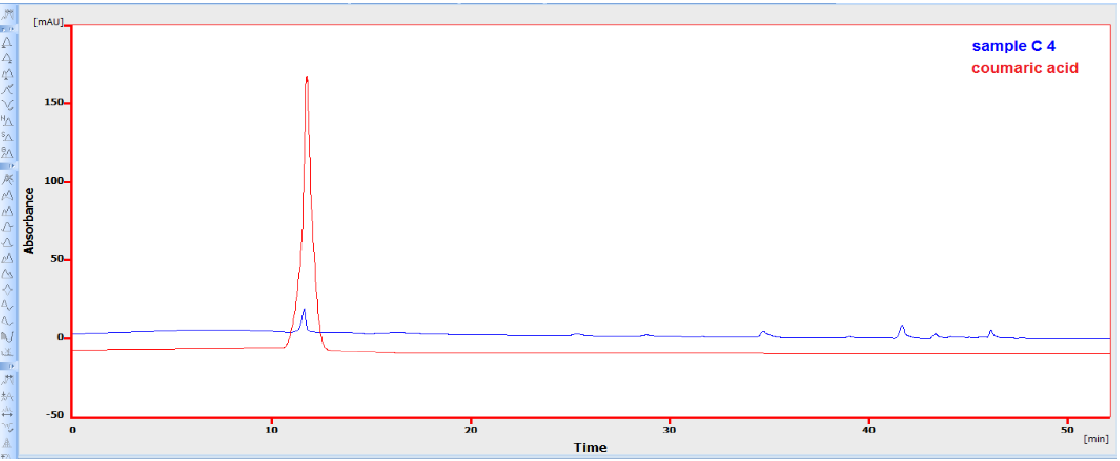
Figure 8. HPLC chromatograme of standard coumaric acid and isolatedcpd C4